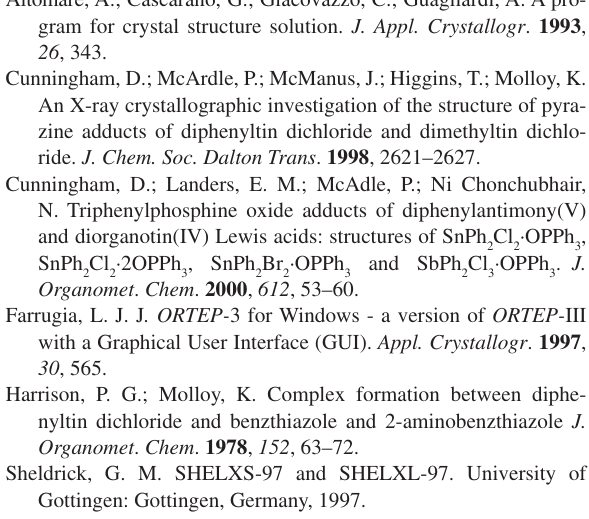
Table 1 Crystal data and structure refi nement .